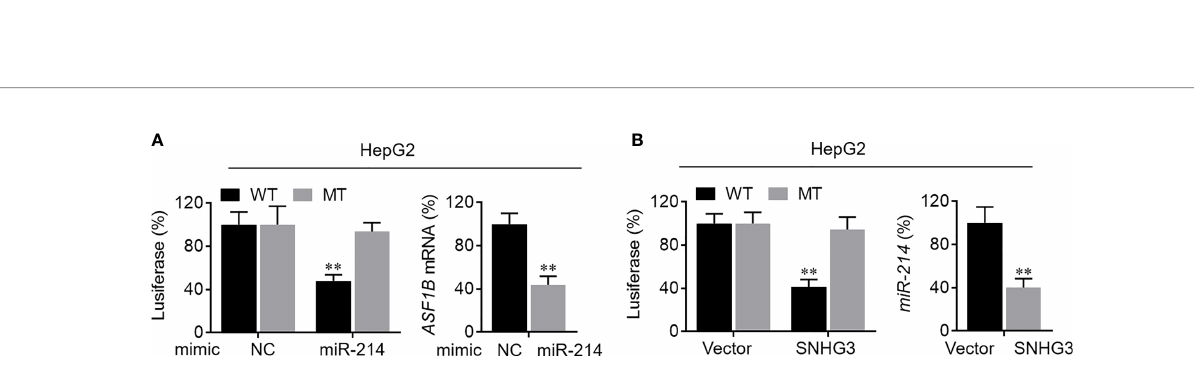
FIGURE 7 | Identi fi cation of potential regulatory axis associated with HCC recurrence. (A) The relationship between the expression of miR-214-3p and HCC. (B) The correlation of LINC00205 and miR-214-3p. (C) The correlation of SNHG3 and miR-214-3p. (D) The correlation of ASF1B and miR-214-3p. (E) The correlation of SNHG3 and ASF1B. (F) A potential regulatory axis and the interactions among SNHG3, miR-214-3p and ASF1B.